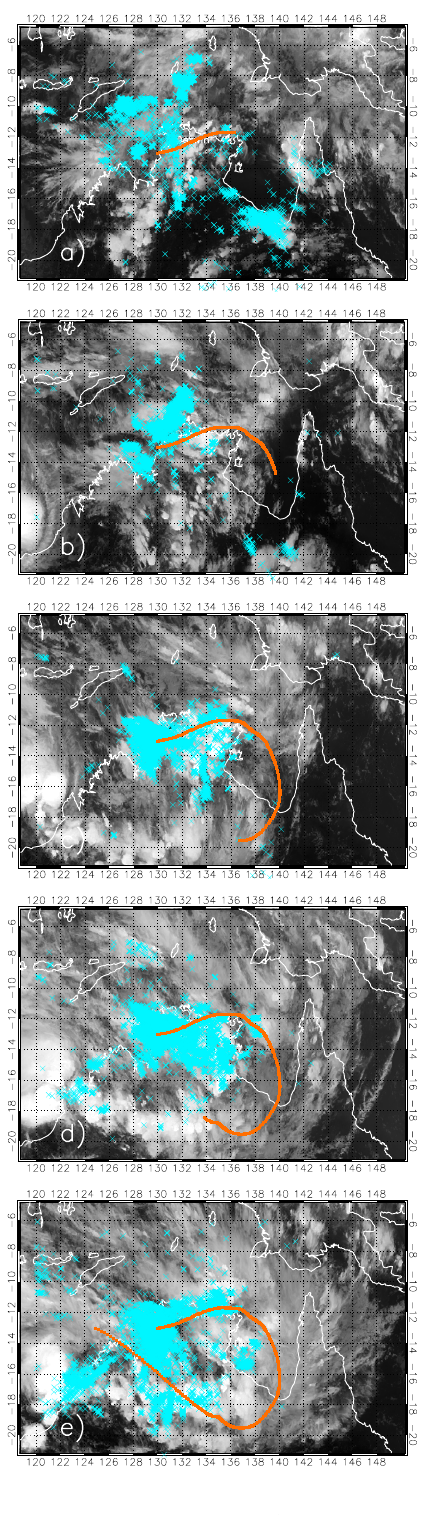
Fig. 8. Location that the back-trajectory from transect 6 has reached for successive 24-h intervals, starting on 22 January (a) through to 17 January (e) , with LINET strokes for the corresponding day overplotted on the 08:30UTC satellite image for that day in each